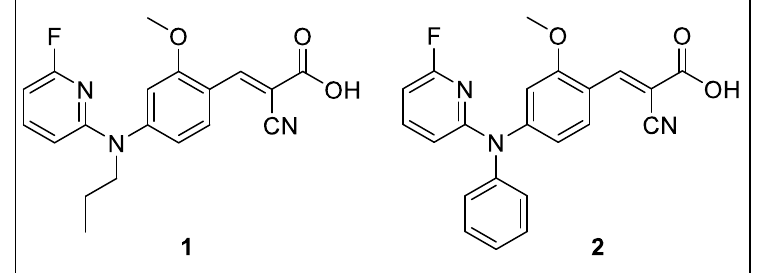
Figure 3. New analogs of FACH investigated in the current study.